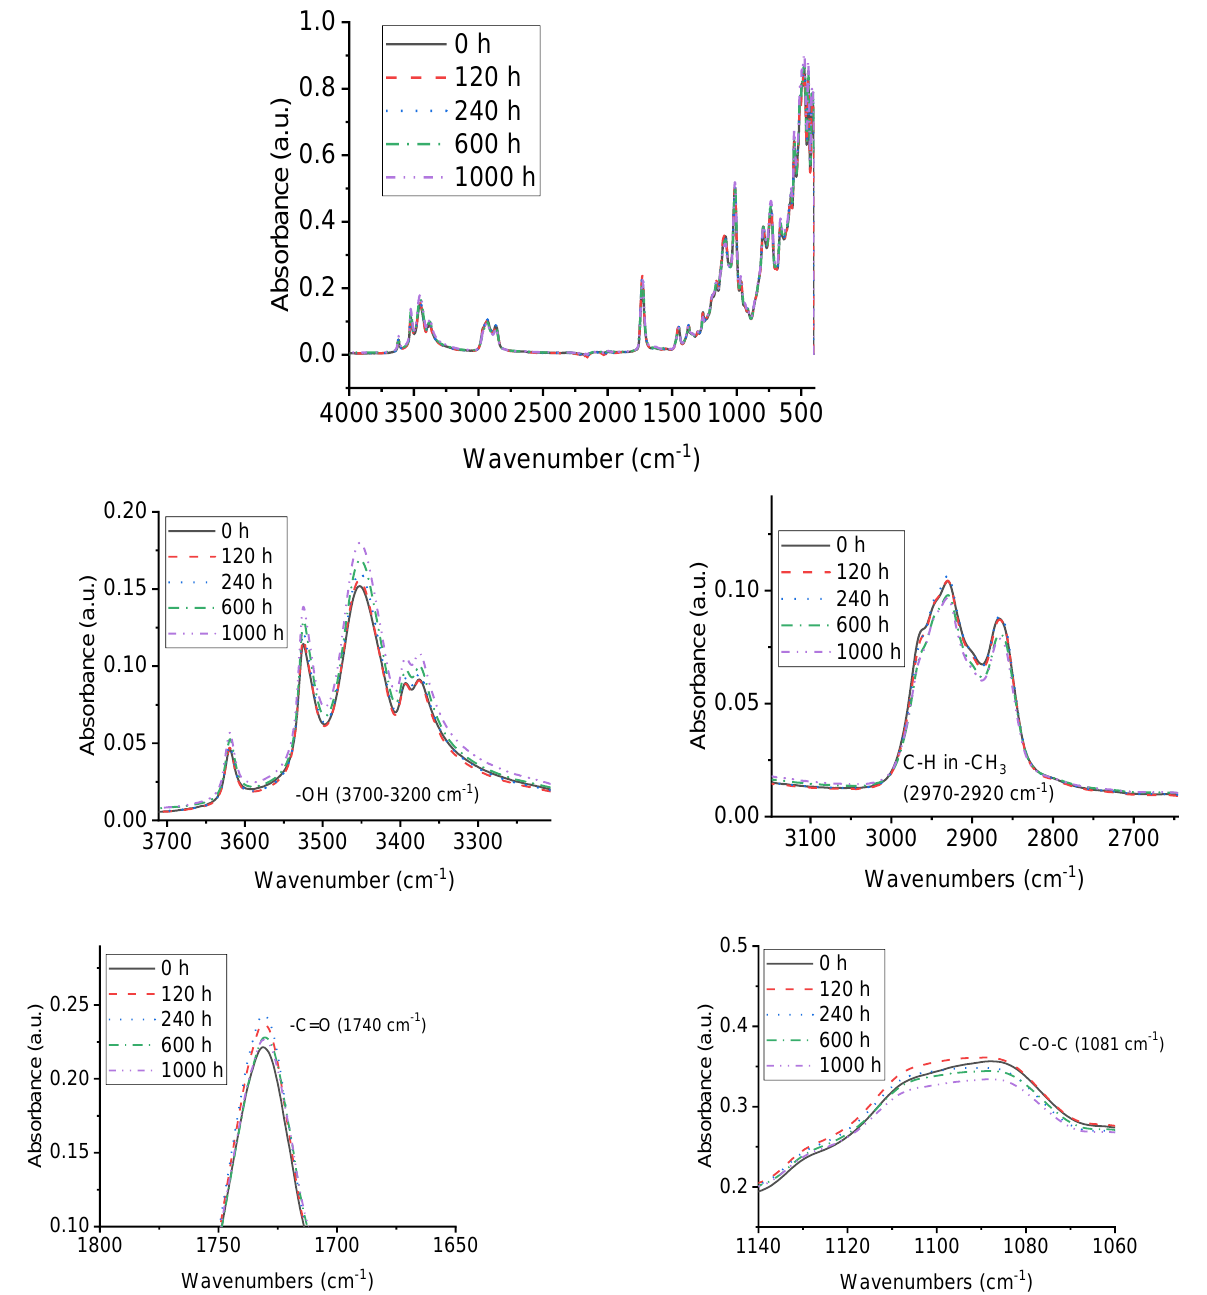
Figure 10. FTIR analysis of alicyclic epoxy resin samples at different UV-A aging times. Table 1. The wavenumbers corresponding to the main chemical bond in alicyclic epoxy resin.